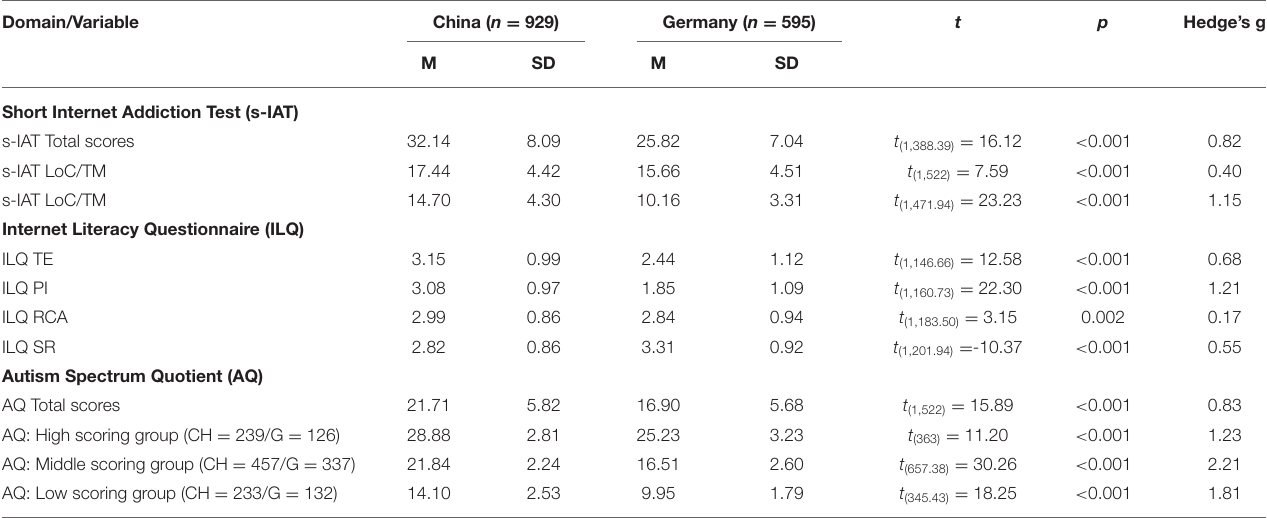
TABLE 2 | Means (M) and Standard Deviations (SD) plus t -tests investigating all psychometric measures depending on the variable German vs. Chinese sample.